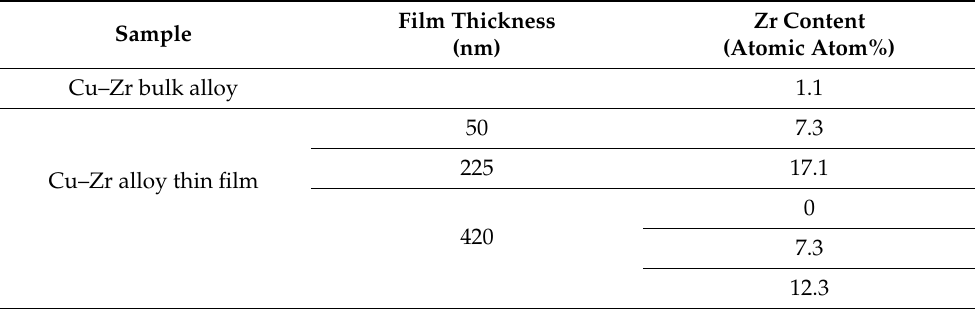
Table 1. Composition of Cu–Zr bulk alloy and Cu–Zr alloy films with di ff erent thickness.